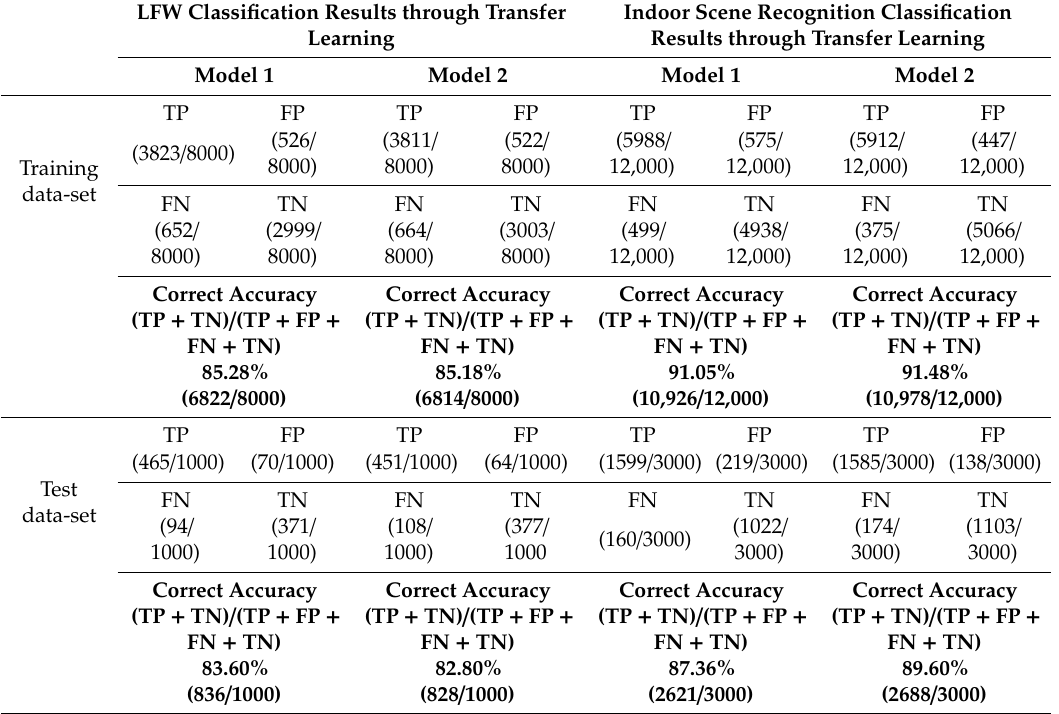
Table 4. Preference classification results from Model 1 and Model 2 using transfer learning with the LFW and Indoor Scene Recognition